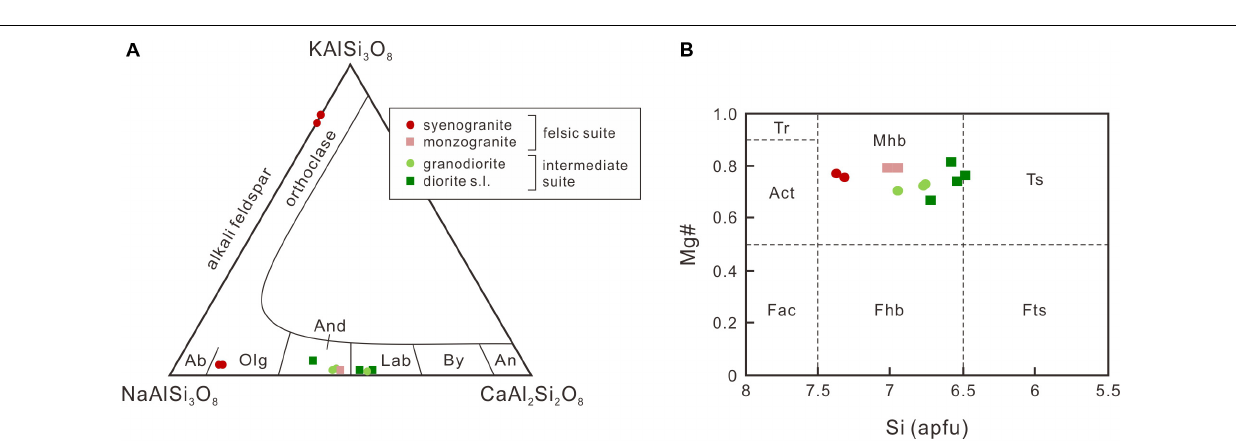
FIGURE 6 | Compositions of plagioclase and amphibole in a subset of the selected samples. (A) KAlSi 3 O 8 –NaAlSi 3 O 8 –CaAl 2 Si 2 O 8 ternary diagram for feldspars. (B) Mg# versus Si binary diagram for amphibole (after Leake et al., 1997). Mineral abbreviations are used after Whitney and Evans (2010), except for minerals that have no recommended abbreviations: Ab = albite, Act = actinolite, An = anorthite, And = andesine, By = bytownite, Fac = ferroactinolite, Fhb = ferrohornblende, Fts = ferrotschermakite, Lab = labradorite, Mhb = magnesiohornblende, Olg = oligoclase, Tr = tremolite, Ts =